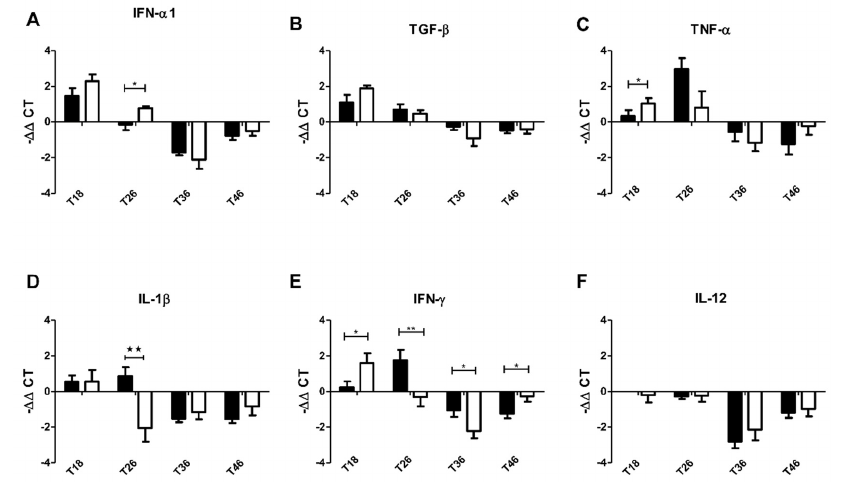
Figure 4. Kinetics of the effect of bacitracin/neomycin on the immunostimulatory capacity of